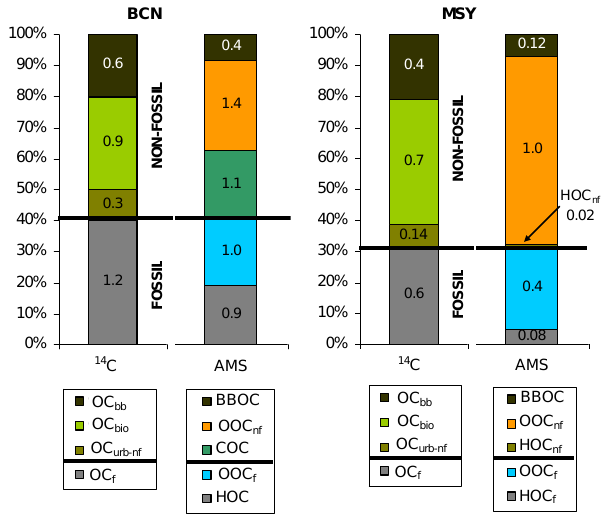
Fig. 7. Concentrations of OC due to biomass burning (µgm − 3 ) estimated with different methods: the 14 C technique, PMF-AMS, levoglucosan-tracer method, and PMF-OF. *: low AMS data avail- ability for the 48h period. Error bars in the 14 C technique account for the uncertainty of the 14 C method and the uncertainty of the (EC/OC) bbe ratio (from 0.2 to 0.4); error bars in the PMF-AMS are an estimation of the uncertainty of the biomass burning contribu- tion; error bars in the levoglucosan-tracer method reflect the vari- ability of the (lev/OC) bbe ratio from 0.07 to 0.17; error bars in the PMF-OF are standard deviation of the four 12h samples included in each of the 48h average periods. Date format: